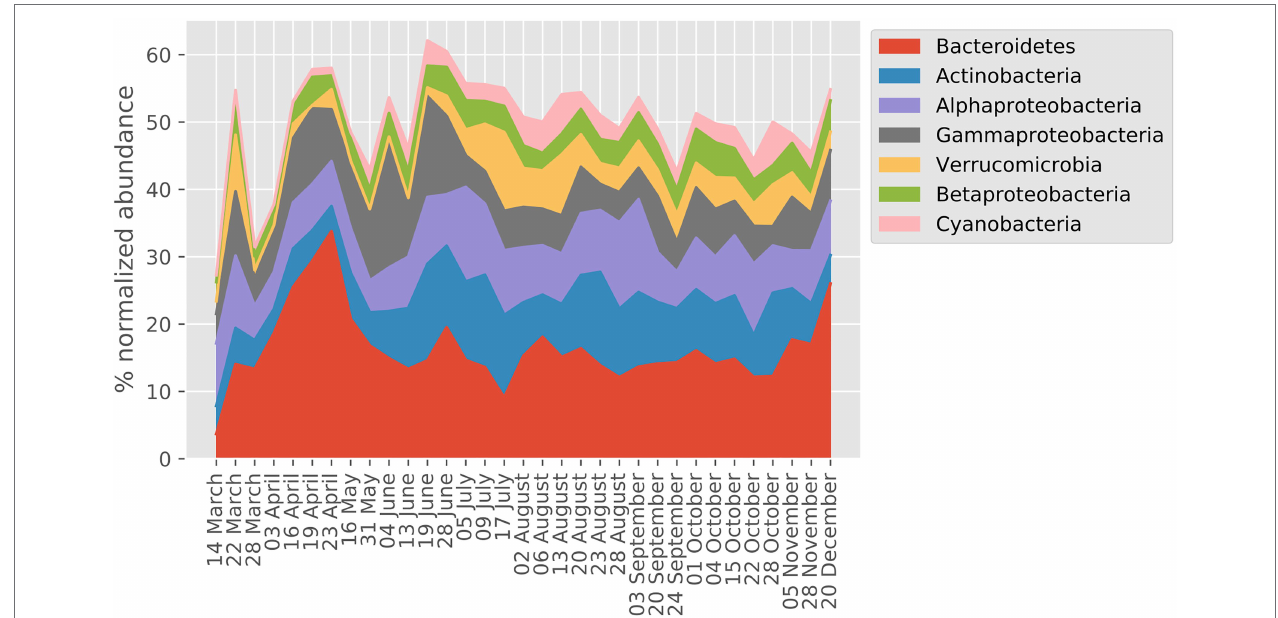
* Std represents standard deviation. Sample dates same as for Figure 7